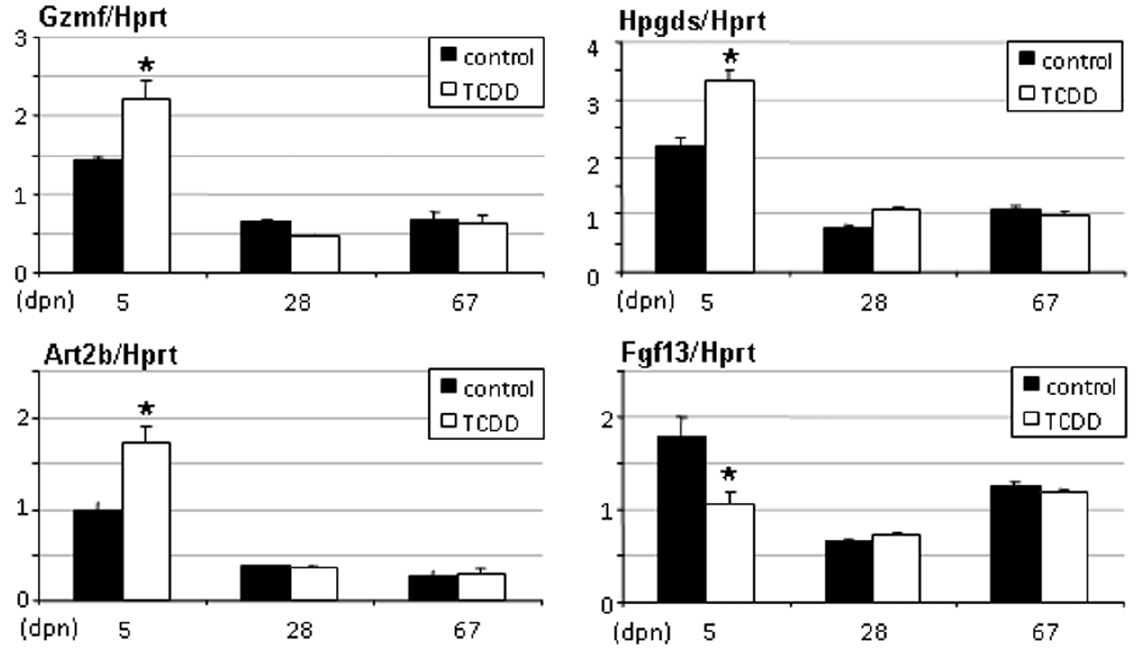
Figure 4. Gzmf, Art2b, Hpgds and Fgf13 gene expression levels in testes of rats exposed in utero to TCDD. Testes were recovered from males of 5, 28 and 67 days of age. Levels were normalized using Hprt. Values are the mean 6 SEM of n=4 animals. *p , 0.05 versus its time-matched control. (dpn), days postnatal.